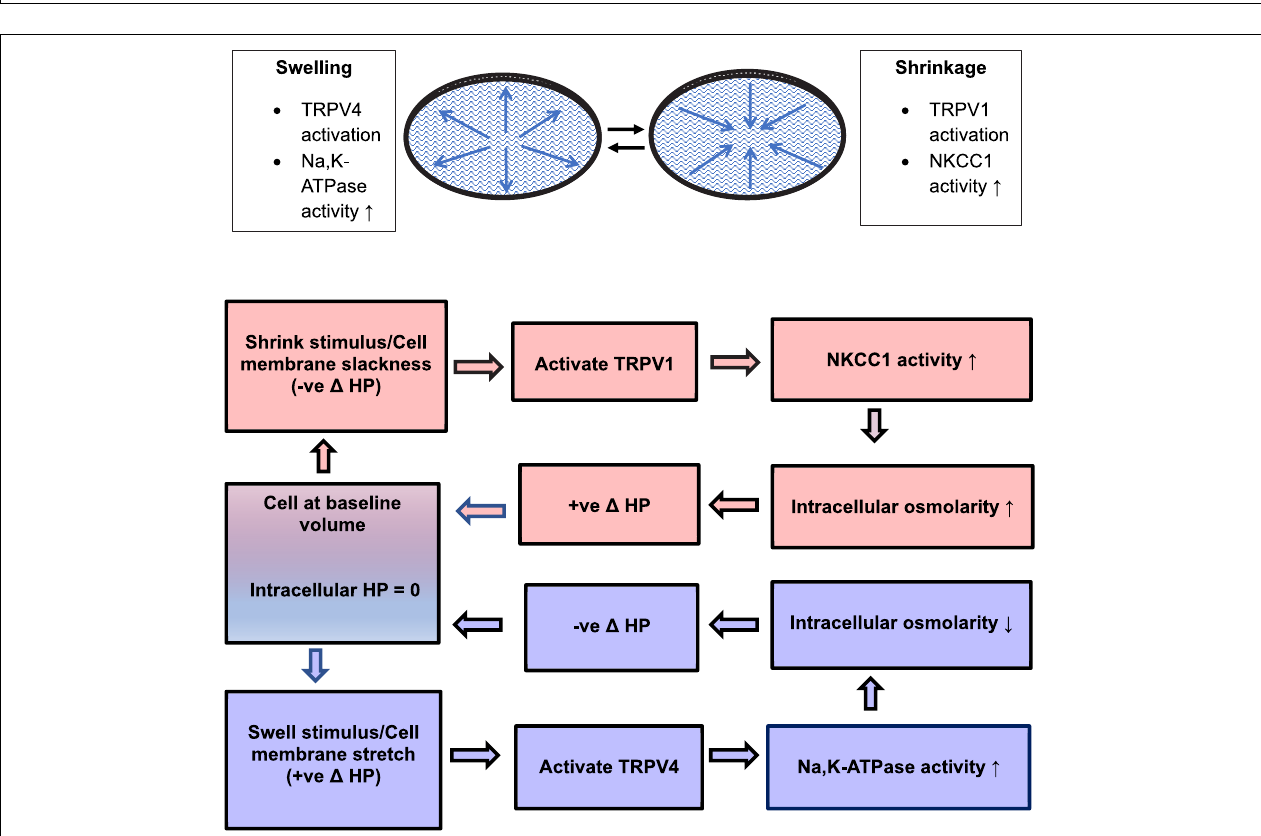
FIGURE 3 | Shrinkage activates TRPV1. Schematic diagram of the TRPV1-initiated signaling cascade that culminates in an increase of NKCC1 activity.